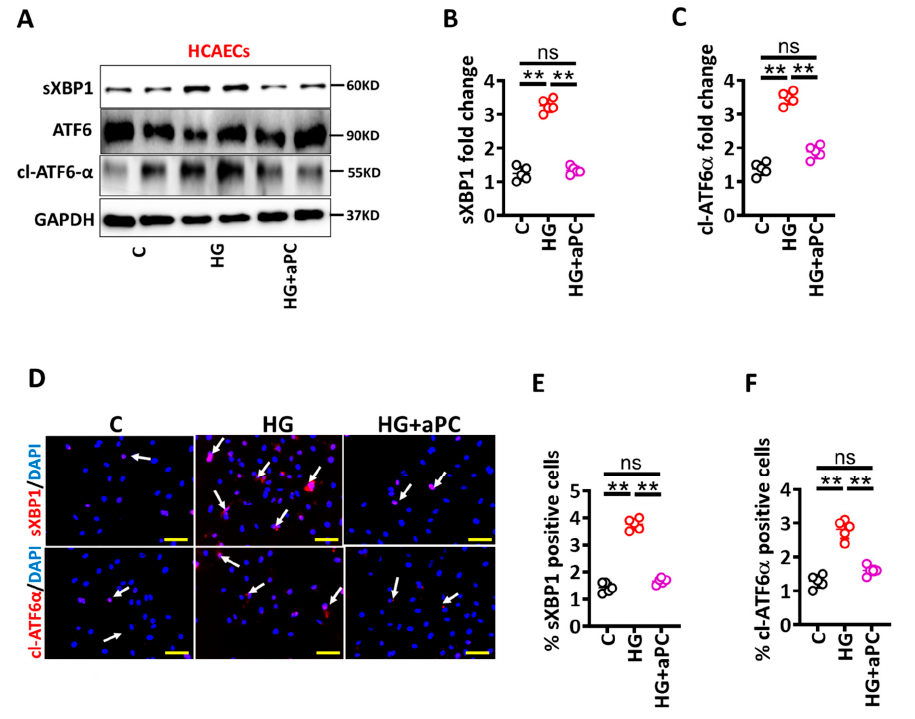
Figure 4. aPC avert glucose-induced UPR. ( A – C ) Representative immunoblots showing spliced XBP1 (sXBP1), total ATF6 and cleaved ATF6 alpha (cl-ATF6 α ) (( A ), loading control: GAPDH). Dot plots summarize densitometric quantifications of immunoblotting results for sXBP1 ( B ) and cl-ATF6 α ( C ). ( D – F ) Representative immunofluorescence images showing staining for sXBP1 (( D ), middle panel, red; nuclear counterstain: DAPI, blue) and cl-ATF6- α (( D ), bottom panel, red; nuclear counterstain: DAPI, blue). Dot plots summarizing immunofluorescence data for sXBP1 ( E ) and cl-ATF6- α ( F ). Scale bar: 20 µ m ( D ). HCAECs maintained under control ( C ), high glucose (25 mM; HG) or HG + aPC (25 mM glucose + 20 nM of exogenous activated protein C) conditions. Each dot represents data obtained from one biological specimen. ** p < 0.01;